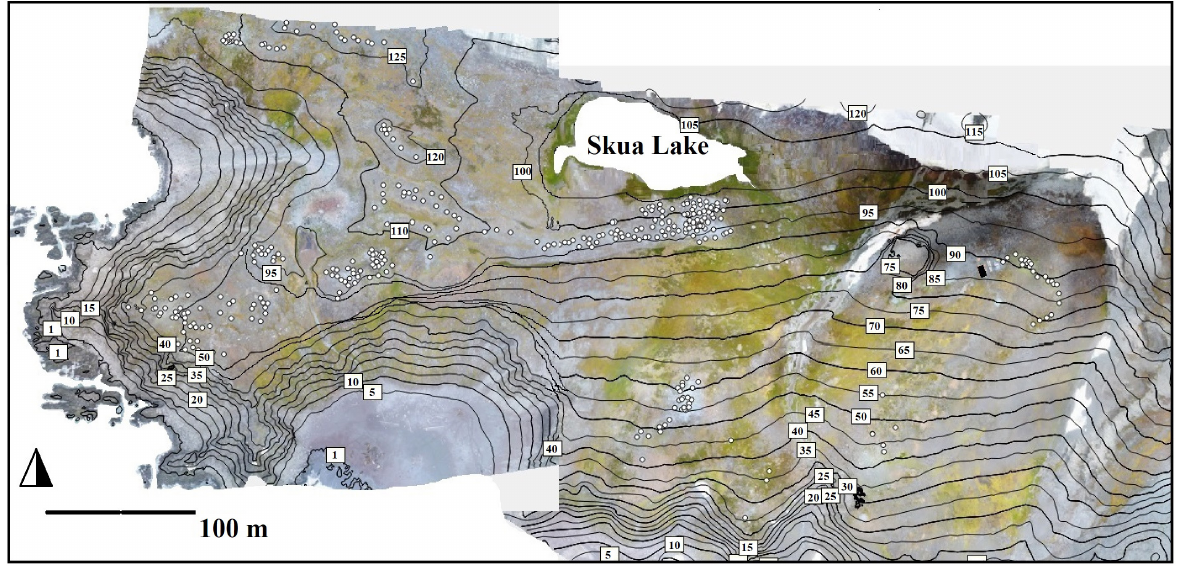
Figure 3. Map of all the southern giant petrel nests found in the Refuge Plateau of Stinker Point (white dots = petrel nests; black square = Brazilian Goeldi Refuge; squares with a number =